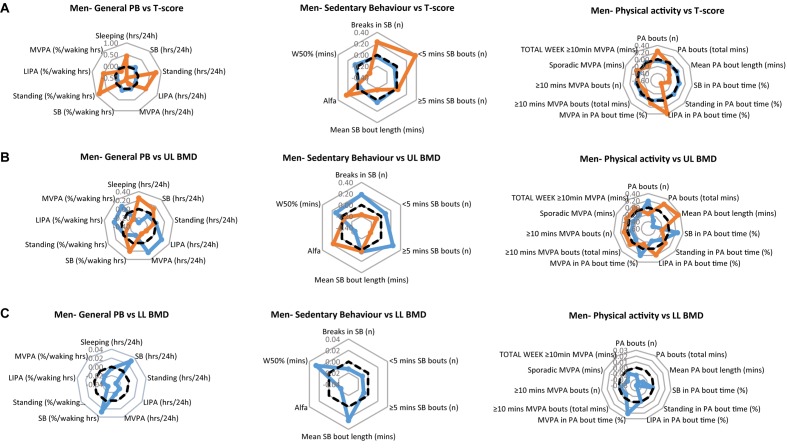
Physical behaviors (PB) in healthy (blue) and osteopenic (orange) men (A) as defined by the whole body T-score, (B) upper limbs BMD T-score, and (C) lower limbs BMD T-score. The radar graphs depict in separate panels (from left to right), general physical behaviors, sedentarism-specific behaviors, and physical activity-specific behaviors. Sample mean is shown in a black dashed line. PB data shown are computed Z-scores.